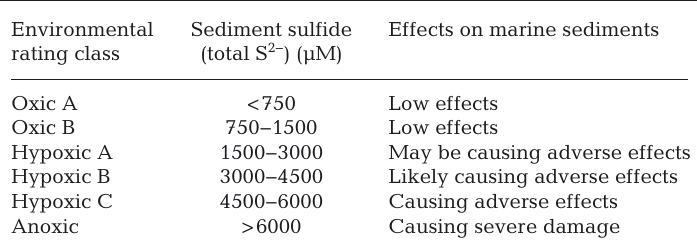
Table 1. Environmental ratings based on average sediment sulfide concen- tration (total S 2− ) in annual monitoring of finfish farms in southwestern New Brunswick. Based on NBDENV